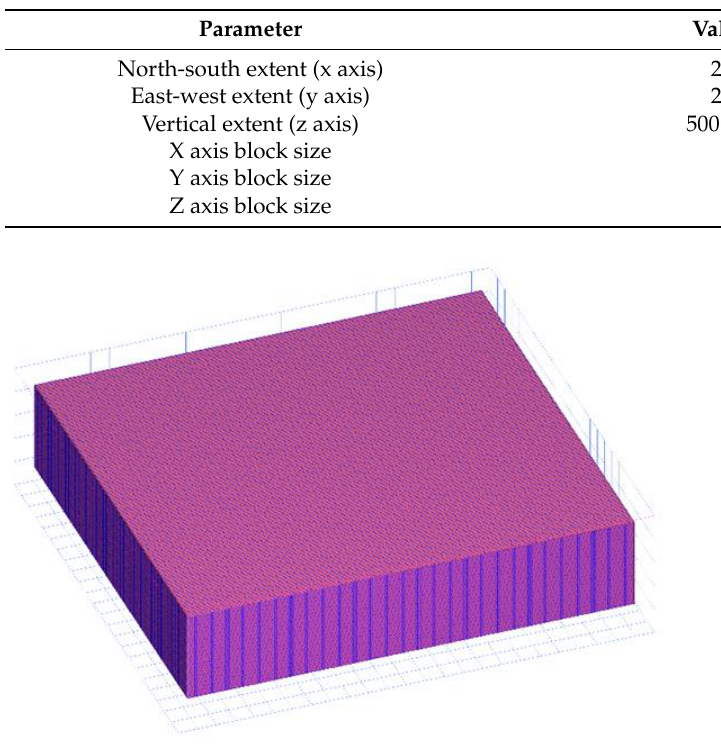
Figure 6. Block model of Xuancheng – Magushan Area.